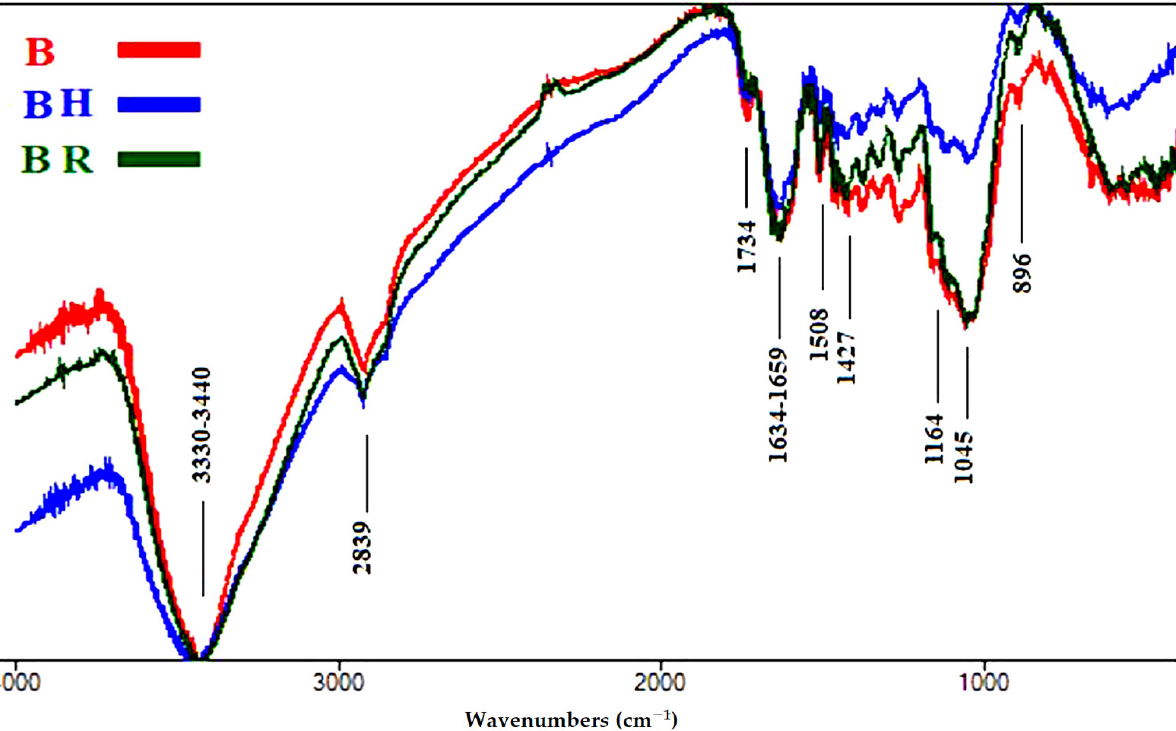
Figure 5. FTIR spectra of the wood samples of Erythrina humeana (B, control; BH, heated ageing; BR, rusted ageing).